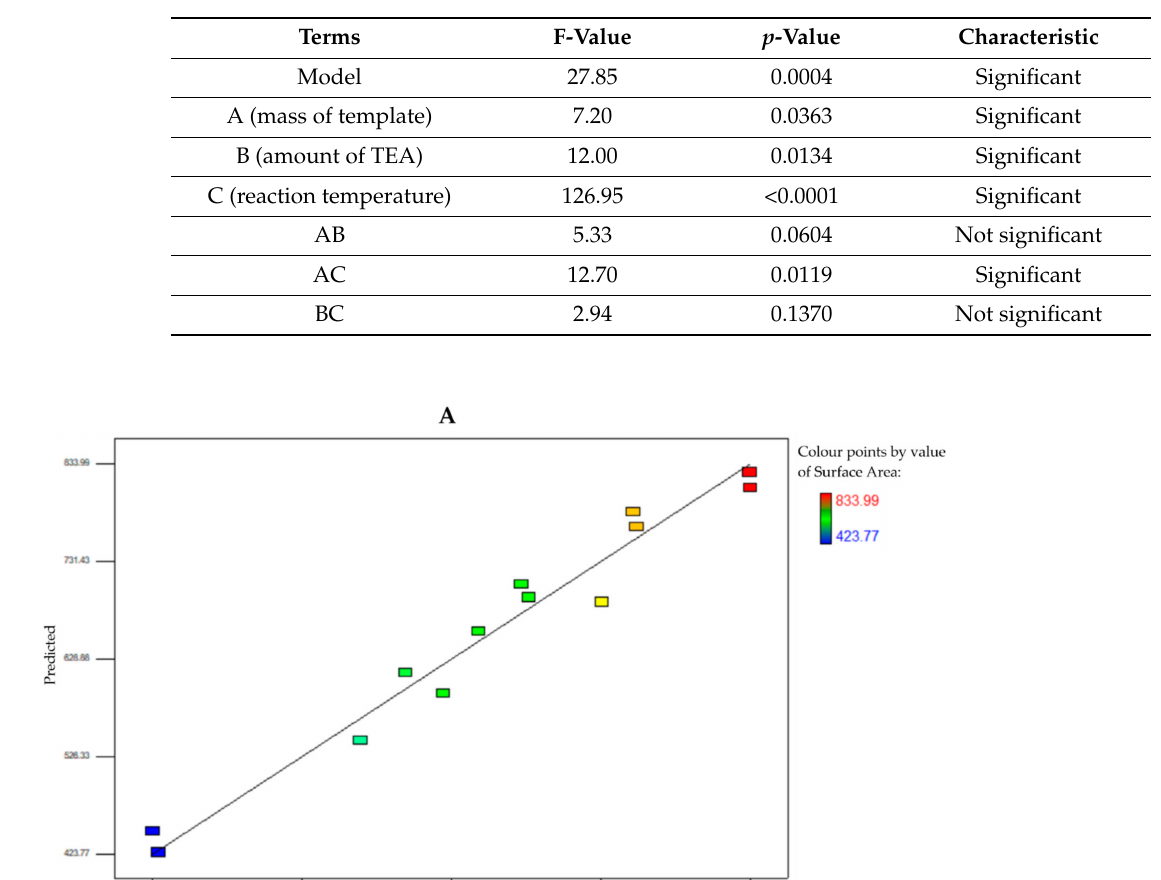
Table 4. ANOVA of the fitted two-factor interaction (2FI) model for surface area of MSNs.